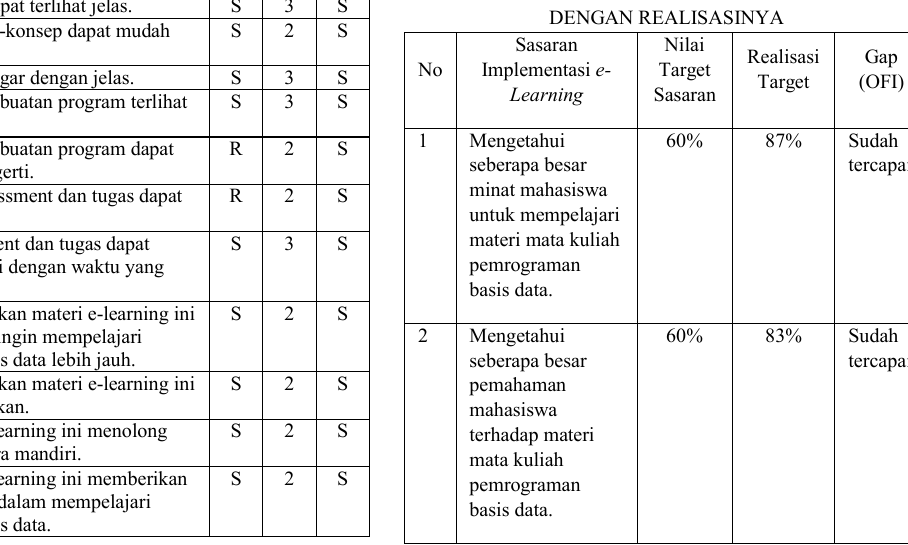
TABEL 8. PERBANDINGAN SASARAN